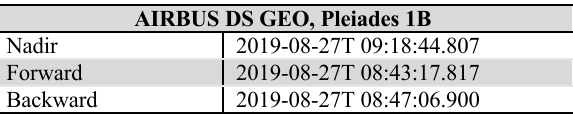
Table 2 . Reference and production date of applied Pleiades